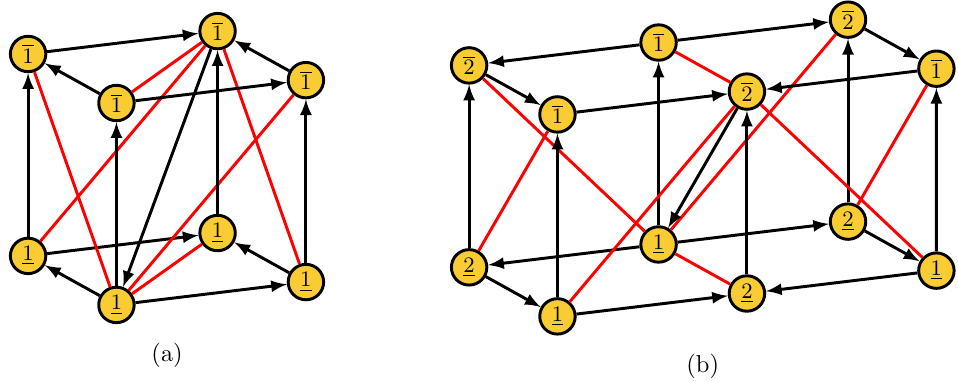
Figure 3. Examples of quiver blocks for: a) C 3 and b) the